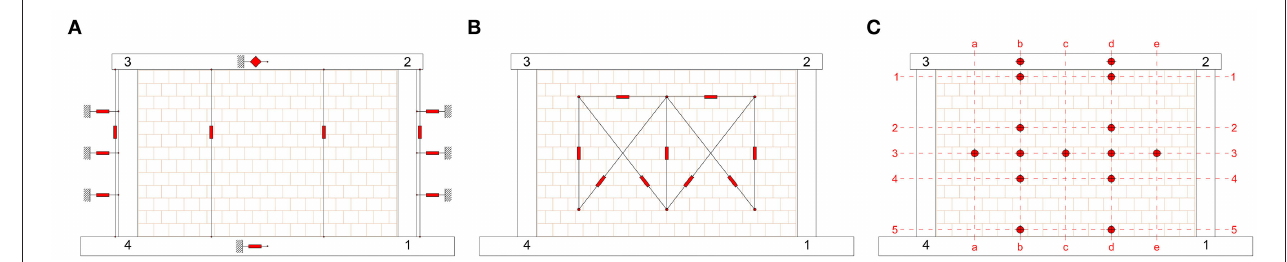
FIGURE 6 | Linear and draw wire potentiometers measuring local and global reinforced masonry frame deformation (A) ; linear and draw wire potentiometers measuring global masonry in-plane deformation (B) ; draw wire potentiometers measuring out-of-plane masonry deflection (C)